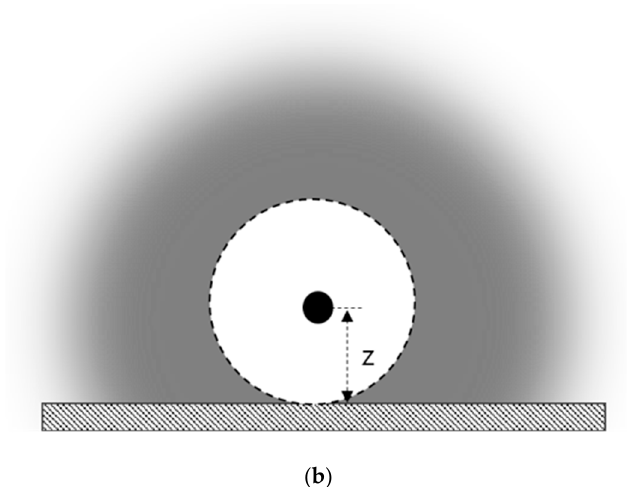
Figure 4. ( a ) Probability density function of particles existing at distance r from the initial position after t . ( b ) Schematic diagram of the probability that a particle at a distance of z from the channel wall will reach the wall after t .